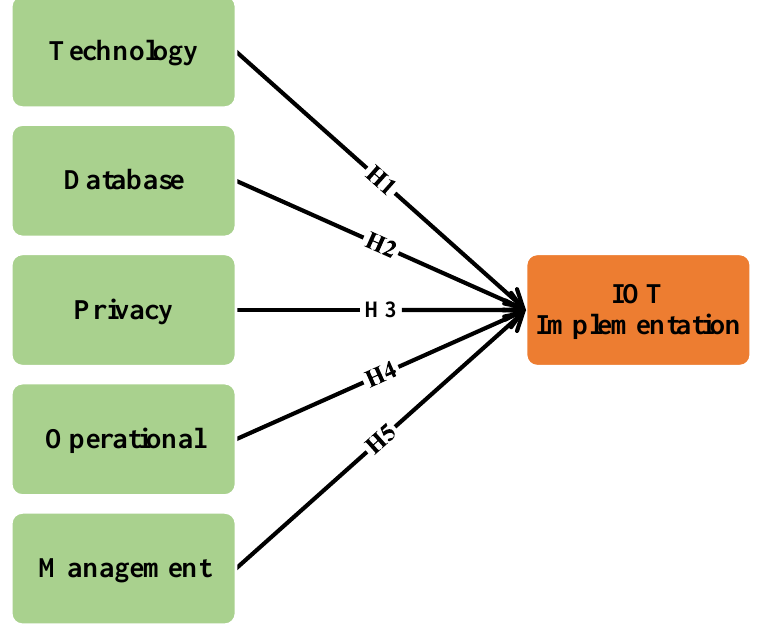
Figure 2. Conceptual framework.